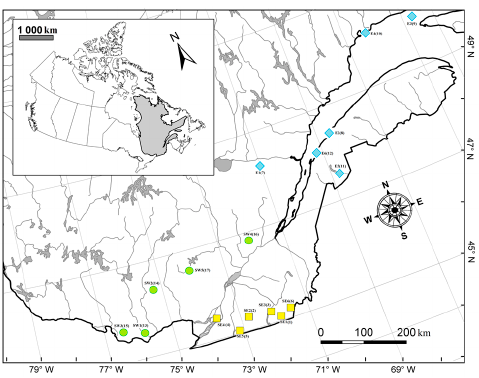
Figure 1. Location of stations. SE = Southeast Hydroclimatic Region (yellow); E = Eastern Hydroclimatic Region (blue); SW = Southwest Hydroclimatic Region (green).